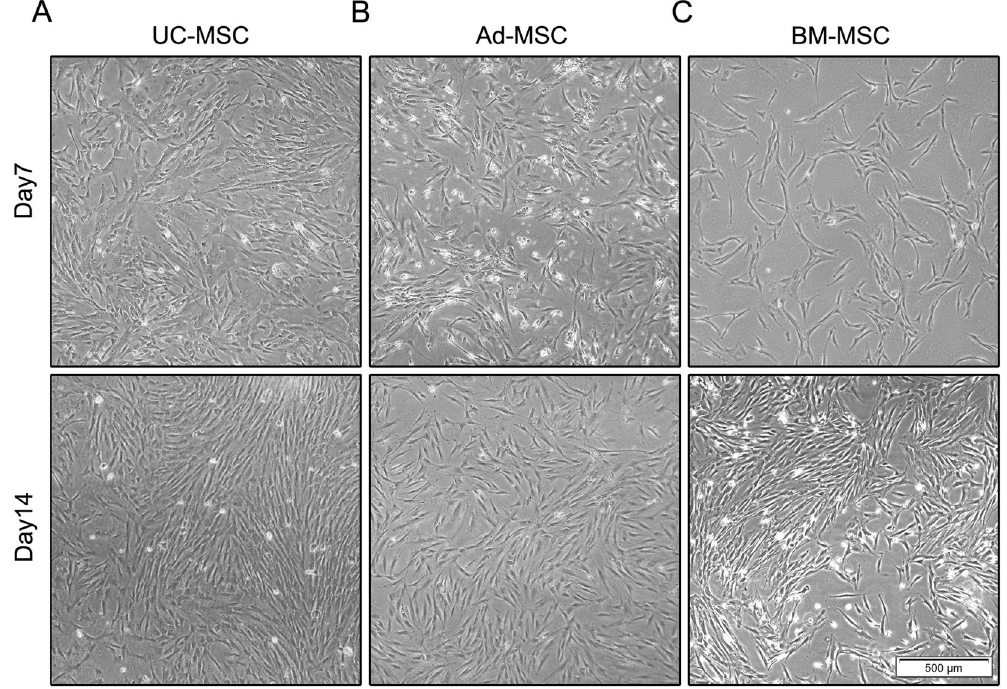
Figure 1. Morphologic comparison of UC-MSC, Ad-MSC and BM-MSC. UC-MSC. ( A ) Ad-MSC ( B ) and BM- MSC ( C ) were isolated and captured using the IX71 Olympus microscope at day 7 and day